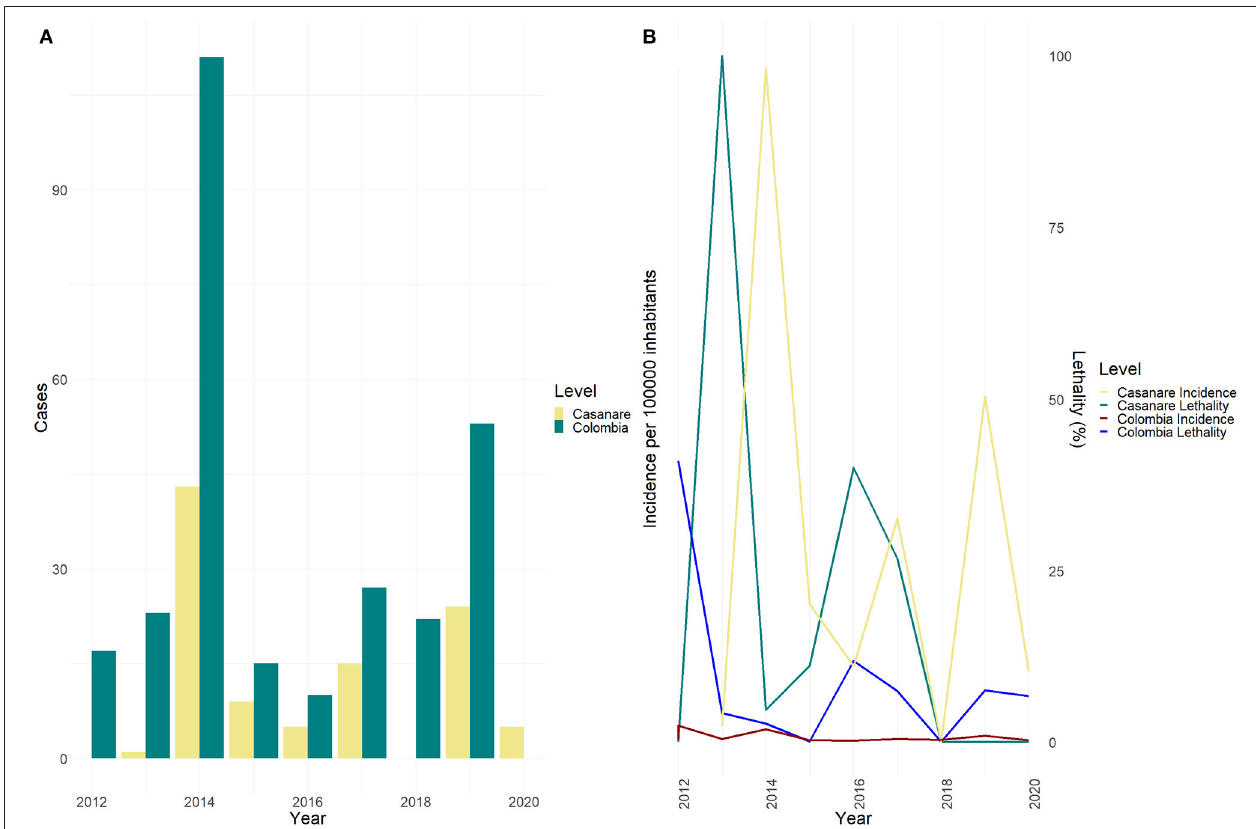
FIGURE 1 | Cases and incidence of Chagas disease by year. (A) Acute Chagas disease Cases by Year, Colombia vs. Casanare 2012–2020. (B) Incidence per 100,000 inhabitants and fatality (%) due to acute Chagas disease, Colombia vs. Casanare